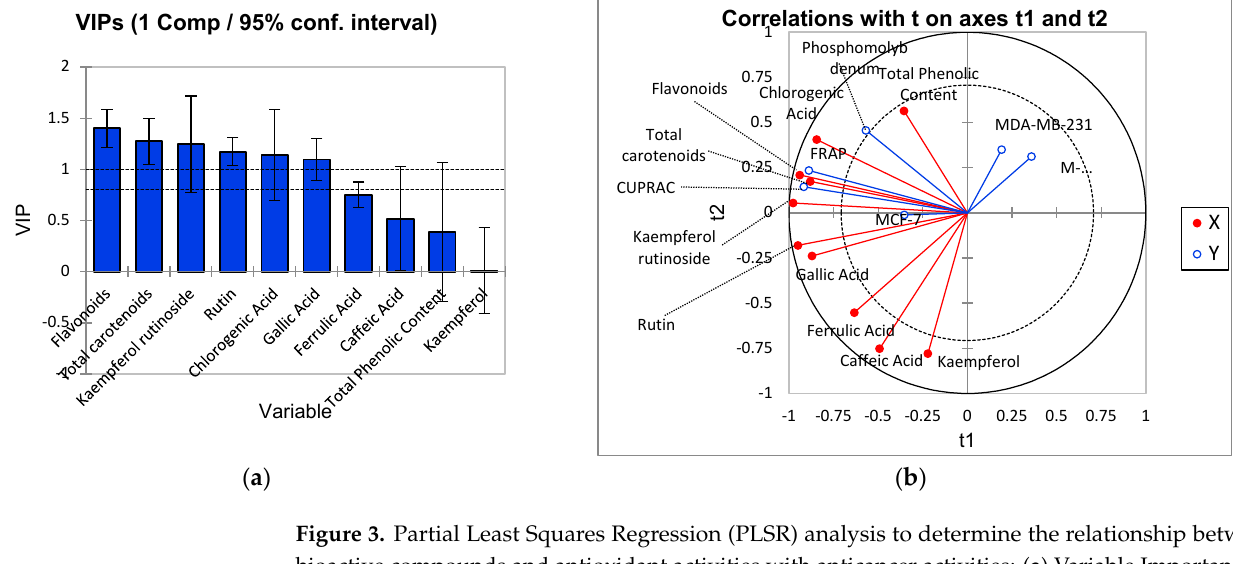
Figure 3. Partial Least Squares Regression (PLSR) analysis to determine the relationship between bioactive compounds and antioxidant activities with anticancer activities: ( a ) Variable Importance in Projection (VIP) plot; ( b ) PLSR correlation plot.